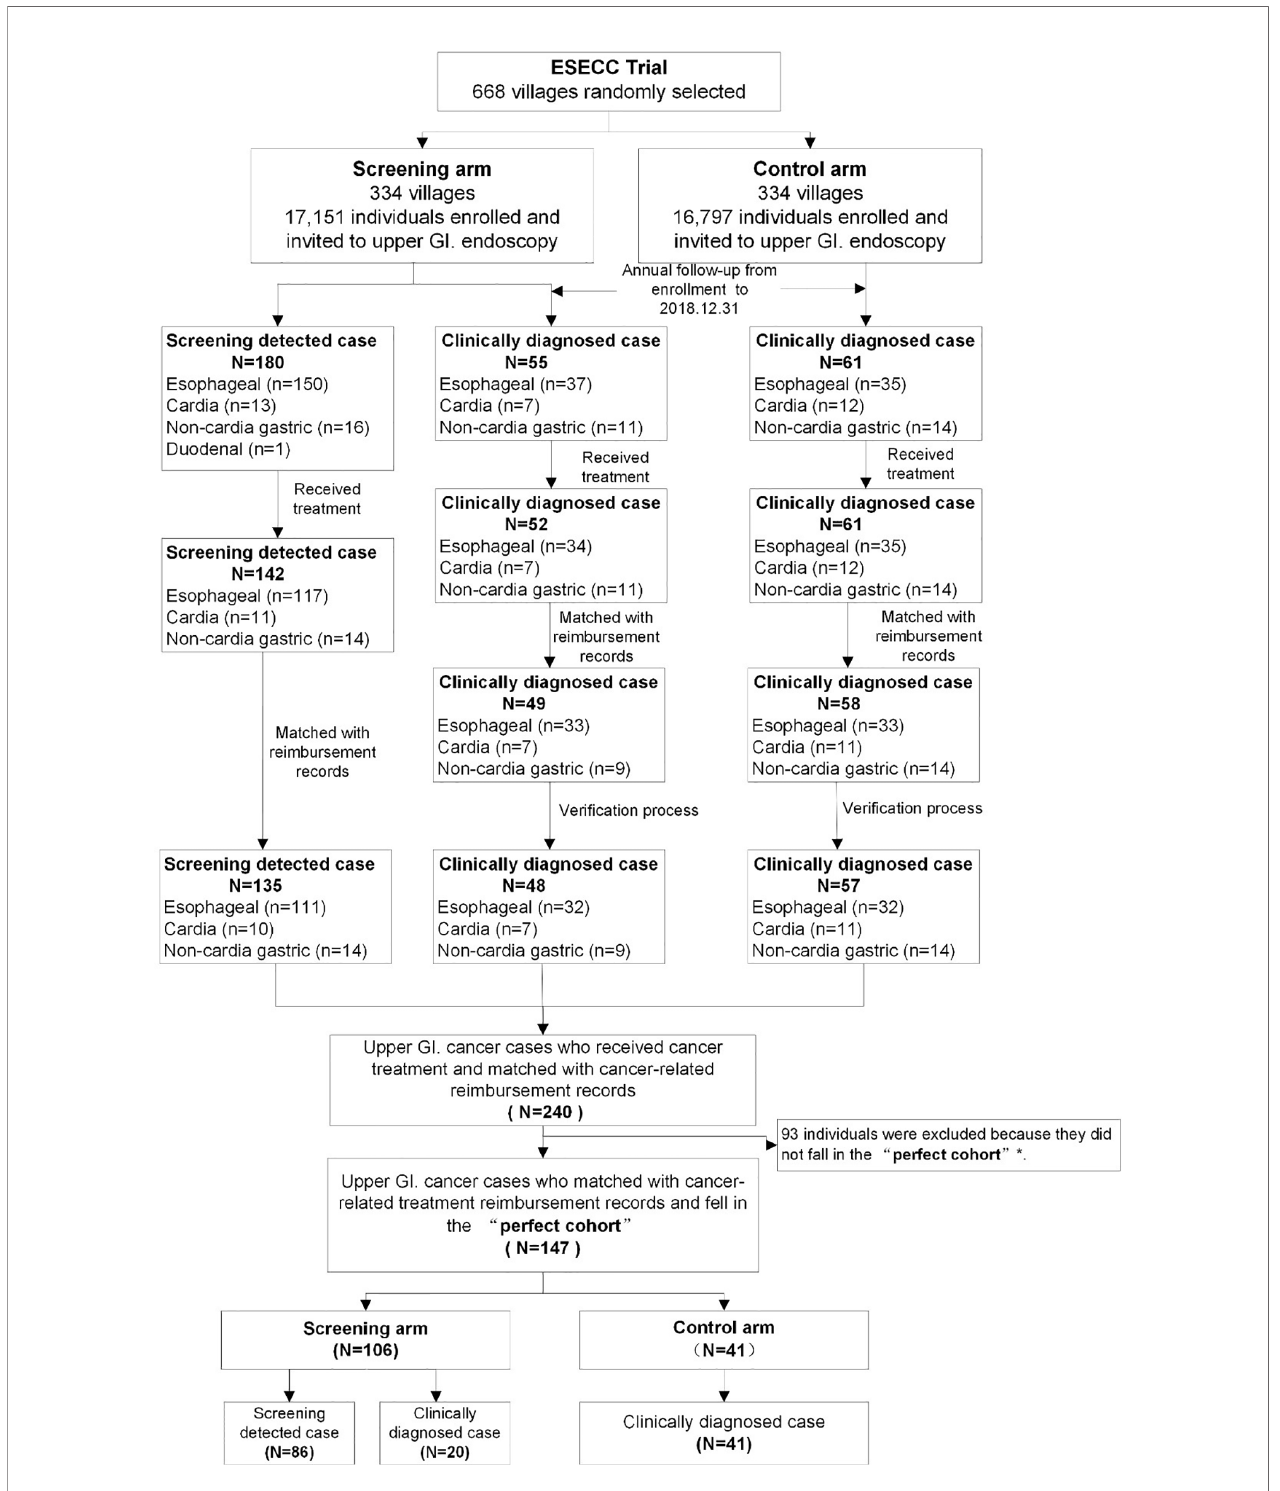
FIGURE 2 | Flow of upper G.I. cancer cases included in the “ Perfect Cohort ” from the ESECC trial. *The “ Perfect Cohort ” refers to all upper G.I. cancer cases from both arms who were diagnosed within 857 days (the shortest follow-up time by the end of 31st December 2018 among all cases) after their enrollment in the ESECC